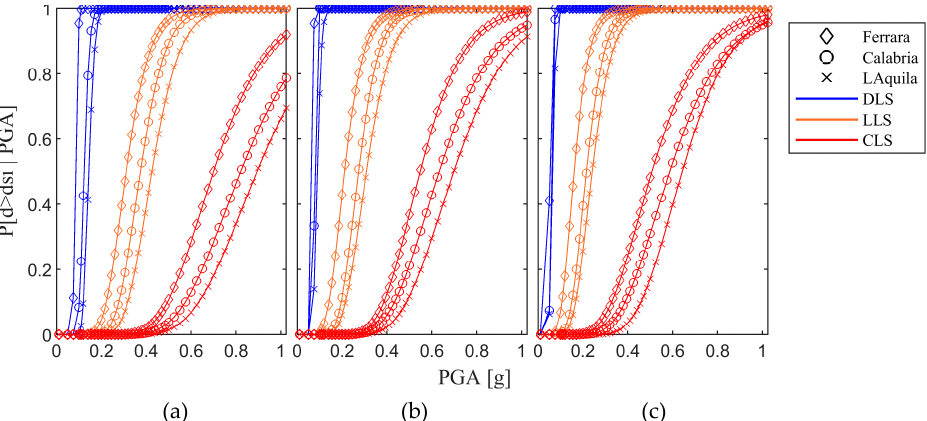
Figure 5. Location influence on FCs; ( a ) Soil A; ( b ) Soil B; and ( c ) Soil C. Figure 6. Location influence on FCs; ( a ) Soil A; ( b ) Soil B; and ( c ) Soil